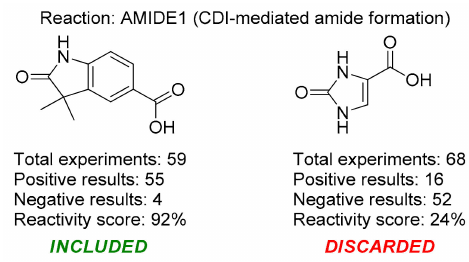
Figure 2. Selection of building blocks for REAL Space